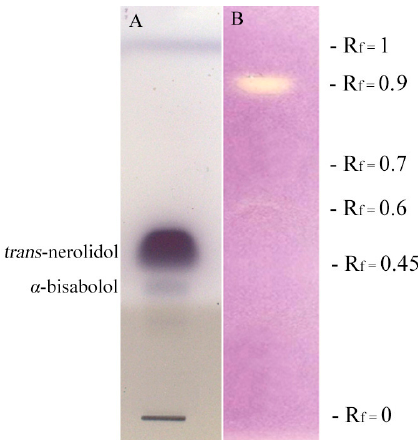
Figure 3. HPTLC bioautographic assay performed for DPPH activity of M. splendens essential oil. R f composition is reported in Table 1. ( A ) HPTLC derivatized with vanillin-phosphoric acid reagent; ( B ) HPTLC derivatized with solution of DPPH radical.